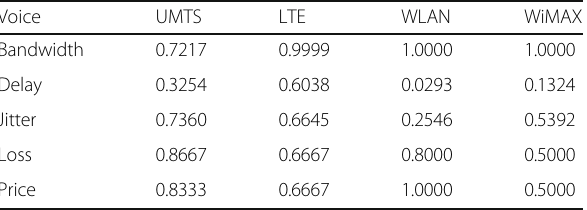
Table 20 Utility values of attributes for video application in